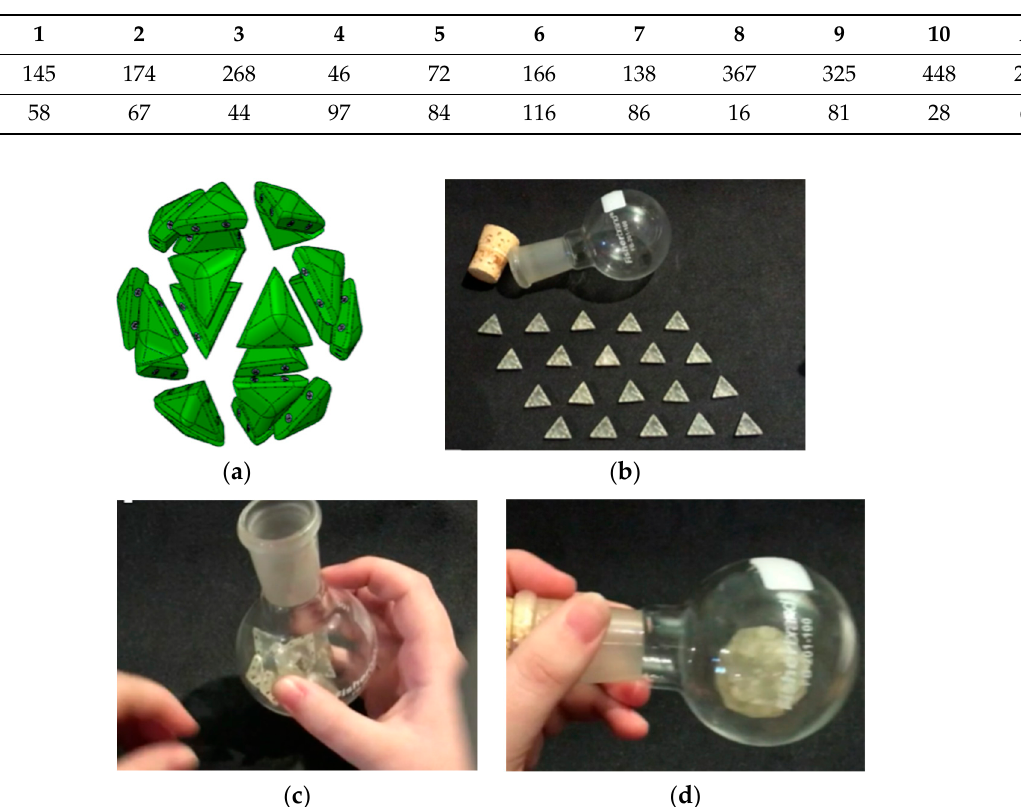
Table 3. Self-Assembly Times (in seconds) of Ten Trials with the Icosahedron in Different Containers.